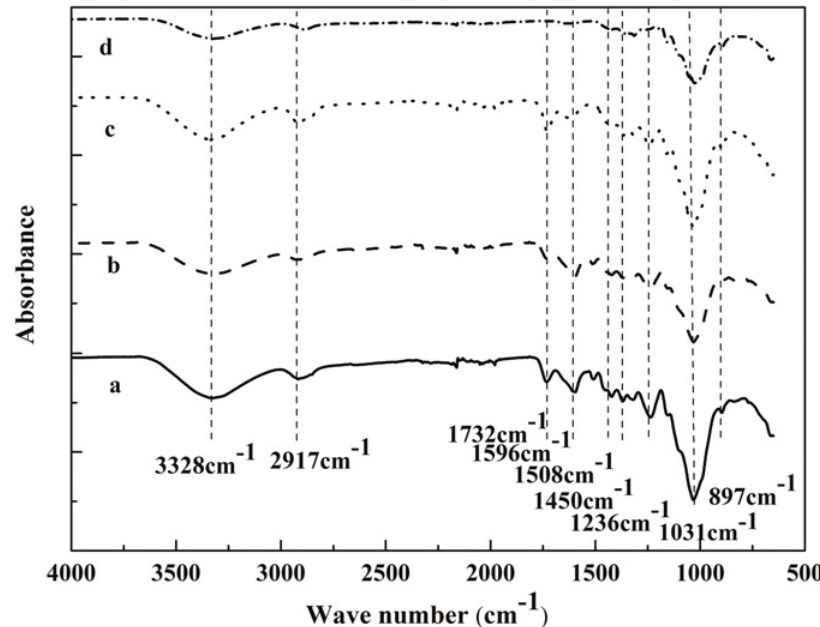
Fig 2. FTIR spectra of fibers at different chemical treatment stages: (a) untreated, (b) benzene/ethanol treated, (c) acidified sodium chlorite treated, and (d) sodium hydroxide treated.